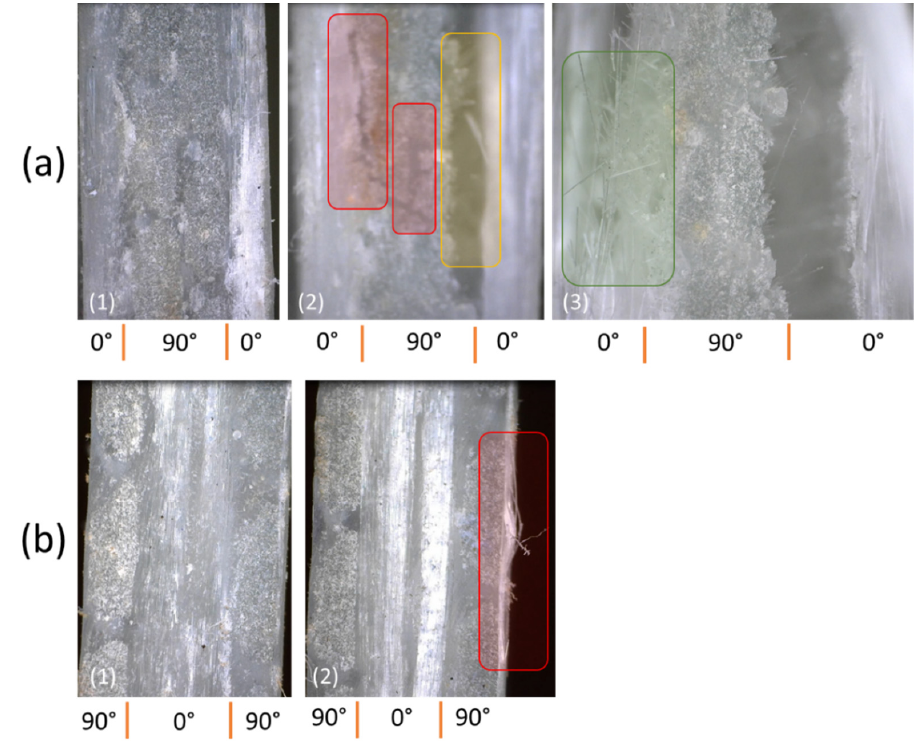
Figure 12. Specimen condition during stepwise loading (1) and after stepwise loading (2)–(3). ( a ) [0/90] S . ( b ) [90/0] S .